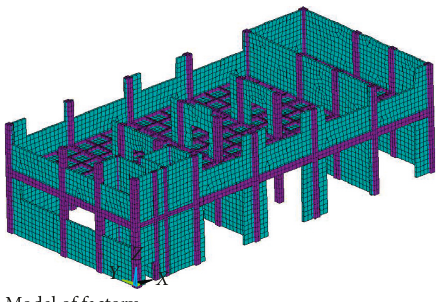
Figure 7: Finite element model of industrial building.